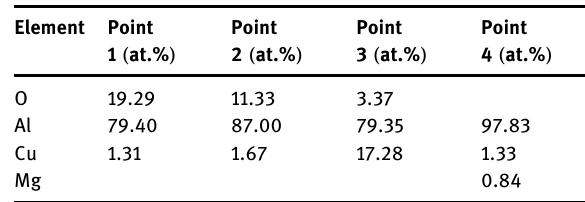
Table 3: EDS Analysis of element compositions at the points indi